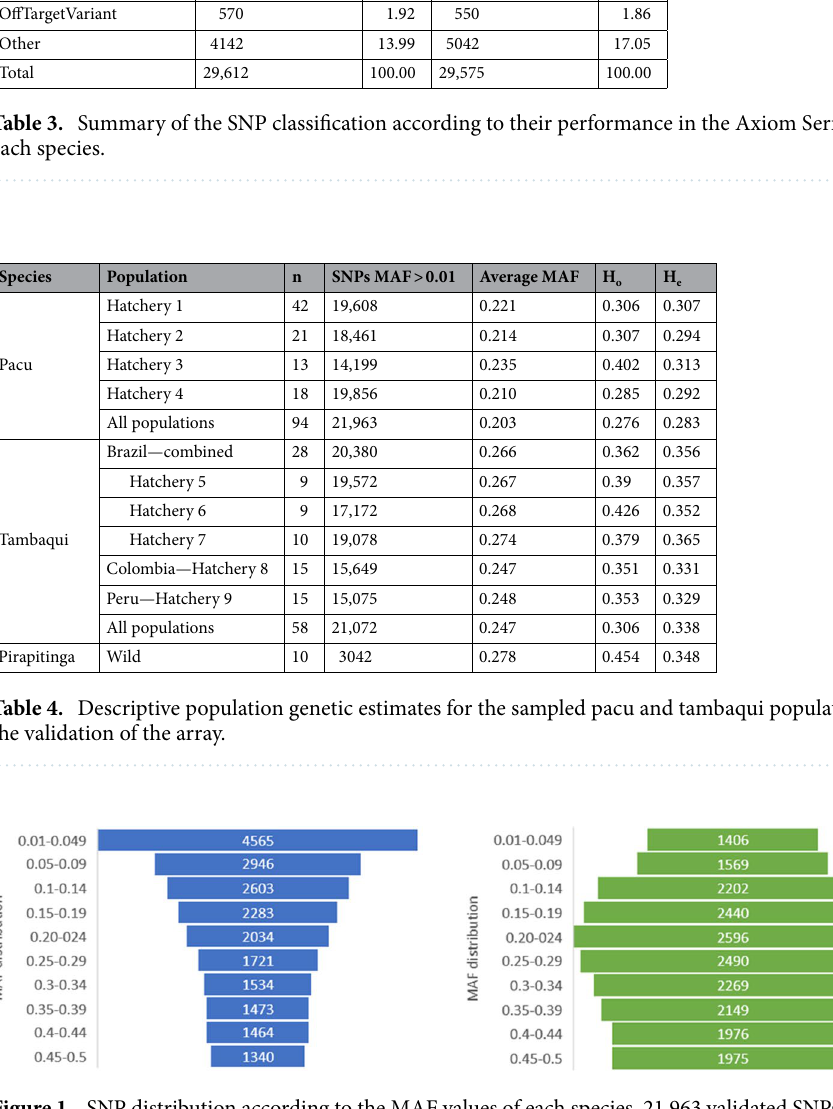
Figure 1. SNP distribution according to the MAF values of each species. 21,963 validated SNPs (74.17%) in pacu (blue) and 21,072 validated SNPs (71.25%) in tambaqui (green) were considered. The validation of SNPs was carried out in 94 pacu and in 58 tambaqui individuals,